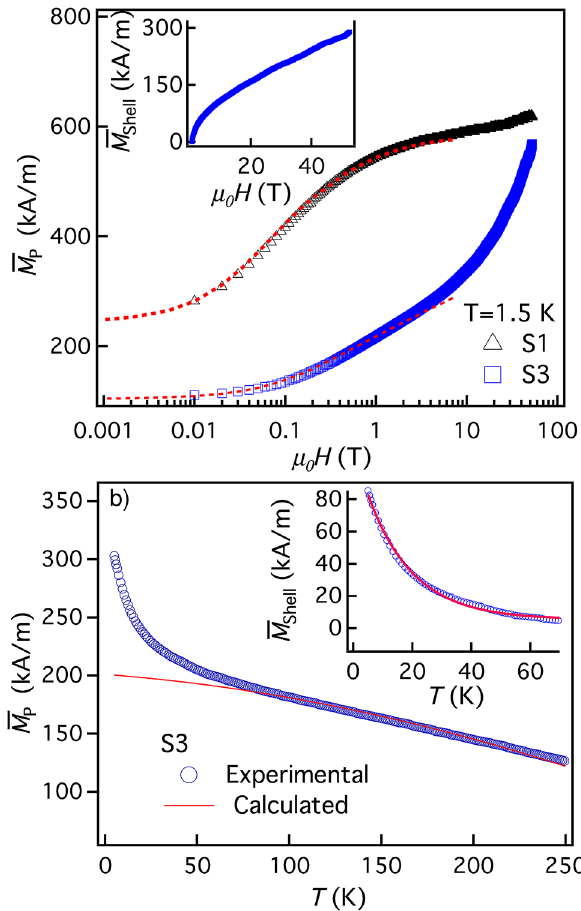
Figure 1. ( a ) Reduced ZFC magnetization M p of samples S1 and S3 under field µ 0 H going down from 52 T; dotted line shows the lower field SQUID calibration. Inset: extracted shell magnetization M sh of sample S3, see “SI”. ( b ) Temperature dependence of M p for sample S3 (open circles) at 5 T; full line renders the core contribution M c ( T ) (see the